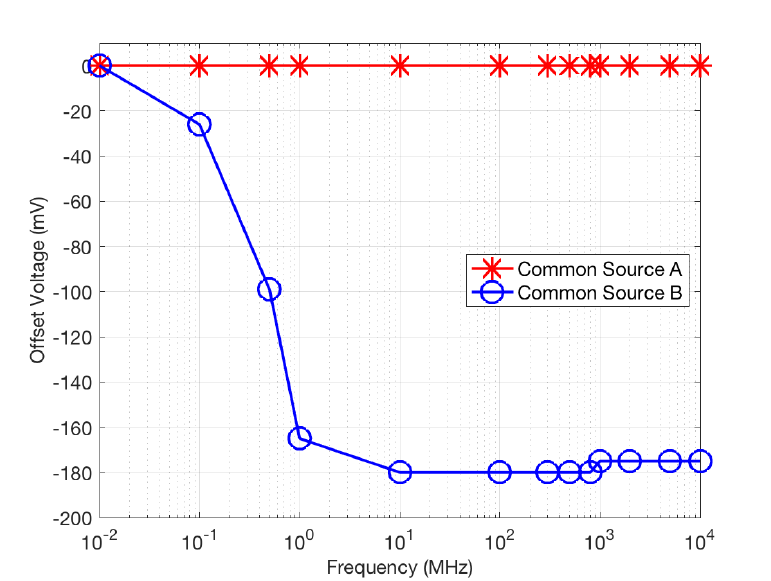
Figure 12. EMI induced offset in the common source